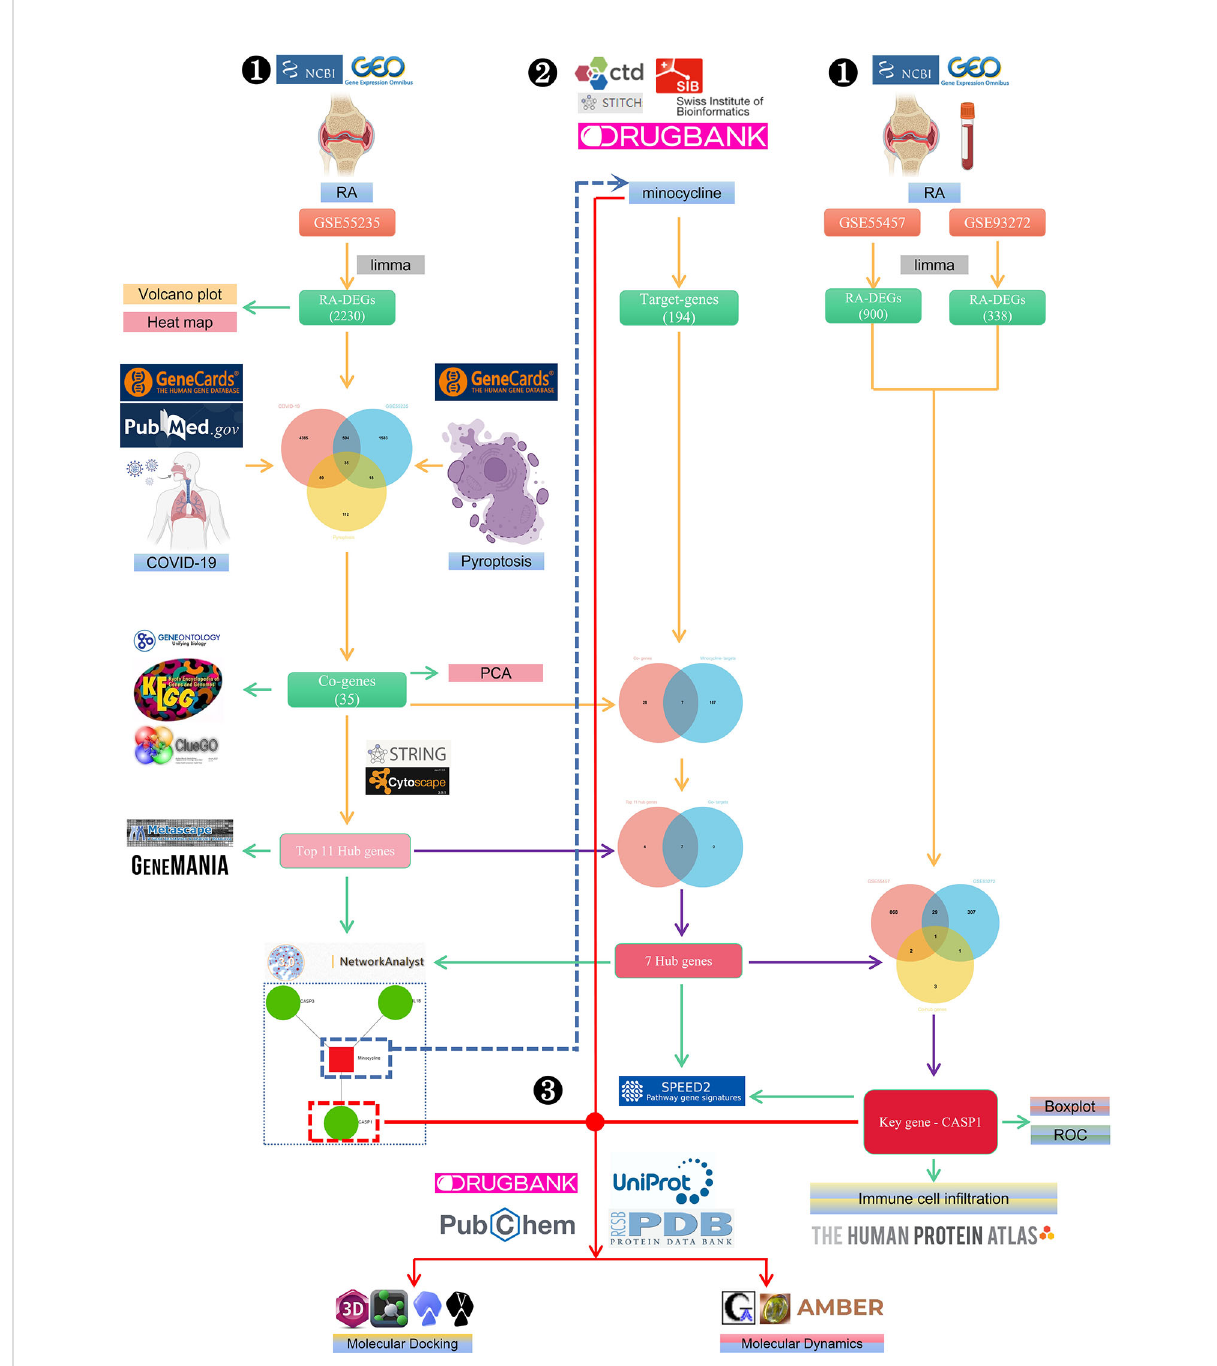
FIGURE 1 The schematic block diagram of the entire work fl ow of this study. ❶ Bioinformatics analysis. ❷ Network pharmacology. ❸ Computer-aided drug